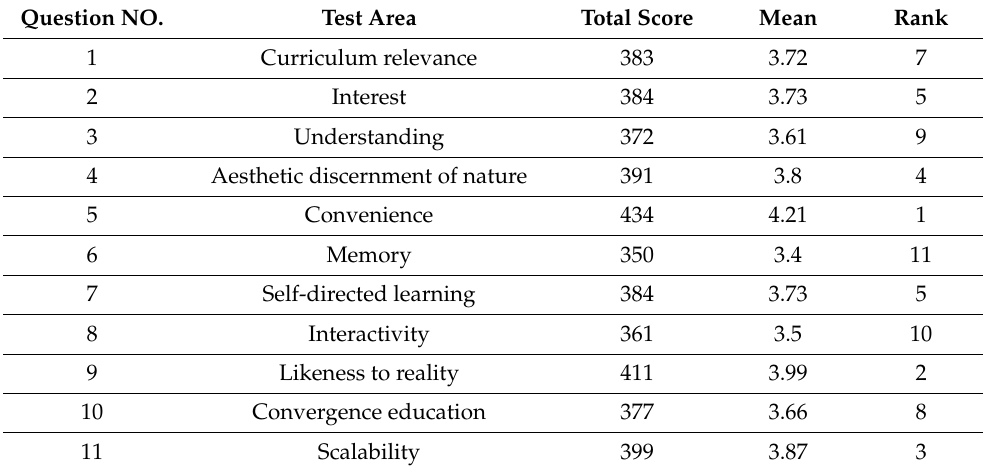
Table 7. Students’ Satisfaction Level with Virtual Field Trip (VFT) Program using 5-point Likert Scale.